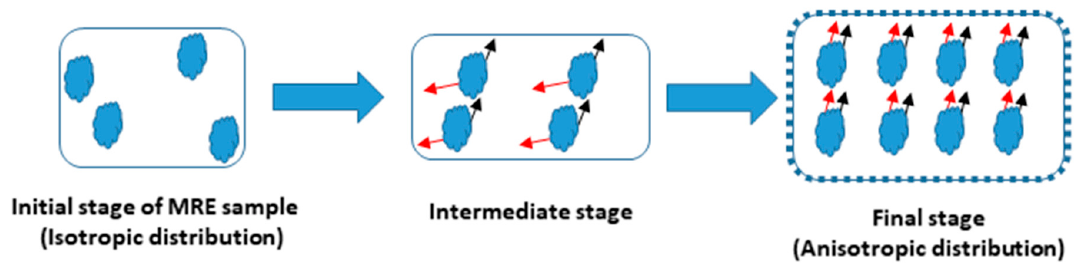
Figure 13. Iron particle distribution before and after the application of the magnetic field.